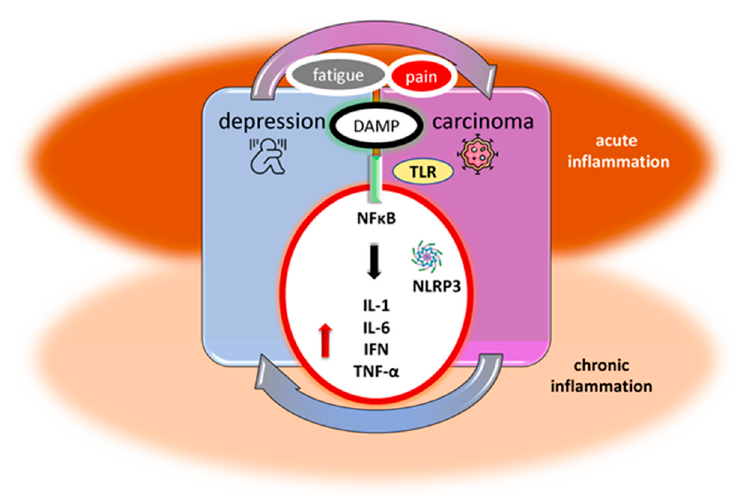
Figure 1. Inflammation as a substrate of depression and carcinoma co-occurrence. Peripheral in- flammation is initiated with DAMPs through TLR, NLRP3, and NF- κ B pathways. DAMPS are molecules released from damaged host cells that can be used as “alarmins”. Pro-inflammatory mediators such as acute-phase proteins, prostaglandins, leukotrienes, oxygen- and nitrogen-derived free radi- cals, chemokines, growth factors, and cytokines released by immune defense cells are particularly important for the early detection of acute inflammation. CRP, fibrinogen, and PCT as part of an innate immune response are detectable in serum within a few hours of inflammation initiation. The pro-inflammatory cytokines IL-1, IL-6, IFN, and TNF- α are elevated in carcinoma and consequently in the brain of patients with pain, fatigue, and depression. Acute and transitory inflammation must be distinguished from chronic and persistent inflammation. Anti-inflammatory strategies could lead to the resolution of inflammation and at the same time stabilization of depression and carci- noma. DAMP—danger-associated molecular patterns; TLR—toll-like receptors; NLRP3—nod-like receptor family pyrin domain containing 3; NF- κ B—nuclear factor kappa-light-chain-enhancer of activated B cells; CRP—C-reactive protein; PCT—procalcitonin; IL—interleukin; TNF- α —tumor necrosis